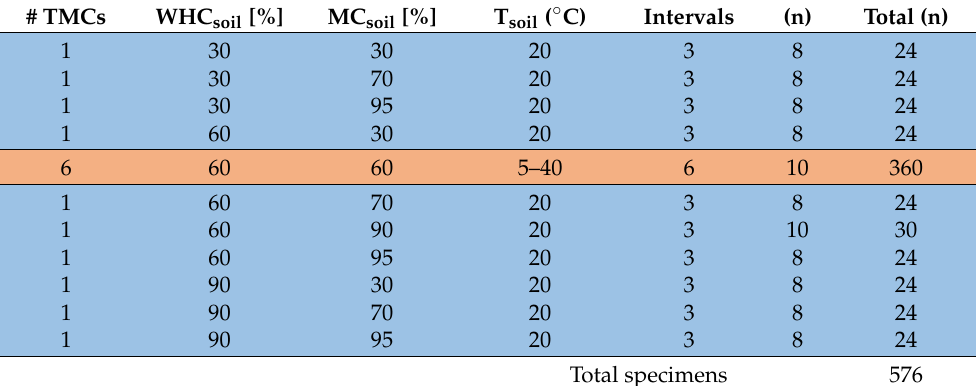
Table 1. Subset of wood decay data (ML wood ) with respective moisture and temperature conditions, and specimen removal intervals, taken from Part 1 [34]. The data was used to develop moisture- and temperature-induced dose components towards a dose–response model for wooden specimens ex- posed to soil contact. Data with blue background was used for the moisture-induced dose component, while data with orange background was used for the temperature-induced component. # TMCs WHC soil [%] MC soil [%] T soil ( ◦